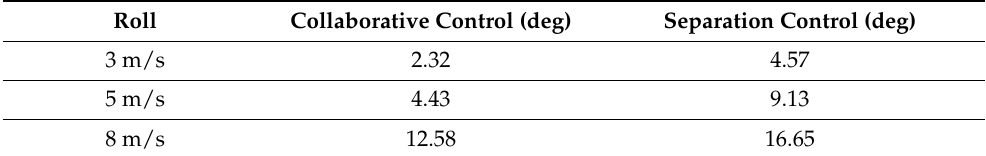
Table 2. Roll angle of the collaborative control and separation control.